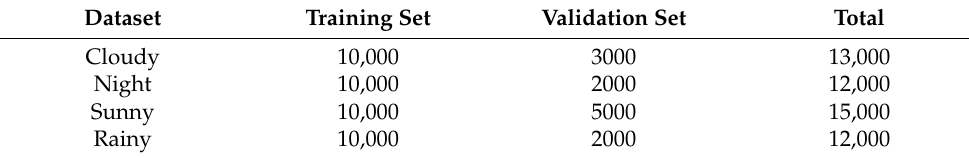
Figure 10. Some samples of the Rope3D dataset were collected under different scenarios and weather conditions. Table 1. Rope3D dataset partition